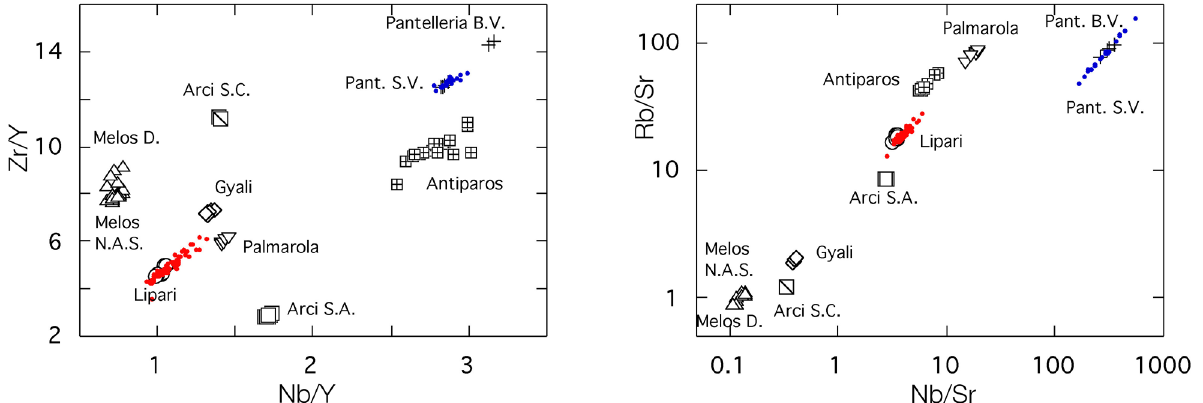
Figure 5: Plots of the WD-XRF X-ray intensity ratios measured on the Casa dei Francesi obsidians: provenance determination revealed source areas from Lipari (91 samples, red points) and the Salto la Vecchia sub-source of Pantelleria (23 samples, blue points). Only 5 samples (USFRA 1, 16, 97, 112, and 115) that are very small or particularly rich in altered spherulites were not plotted because their X-ray intensities gave very different values from those of the database. The literature data on different geological obsidian sources of the Mediterranean basin are from Acquafredda et al. (2018, 2019). Sub-sources outcrops: Monte Arci, S.C. = Perdas Urias; S.A. = Conca Cannas, Canale Perdera, and Riu Solacera. Pantelleria, B.V. = Bagno di Venere, S.V. = Salto la Vecchia, and Balata dei Turchi. Melos, D. =